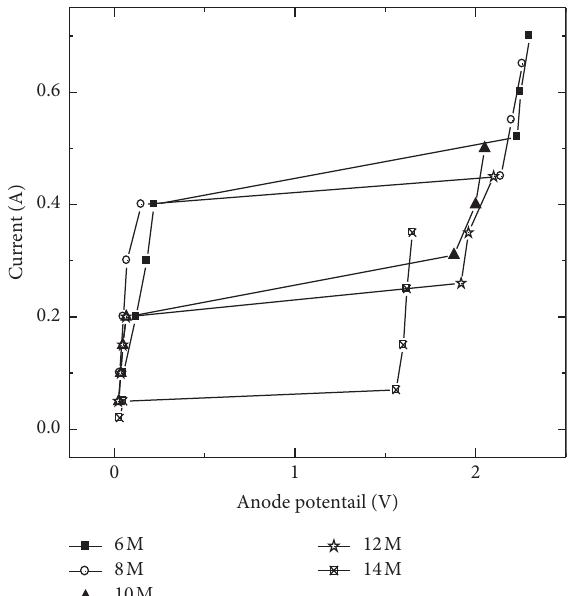
Figure 4: Typical polarization curve for carbon steel electropolishing at 20 ° C in the presence of different concentrations of H